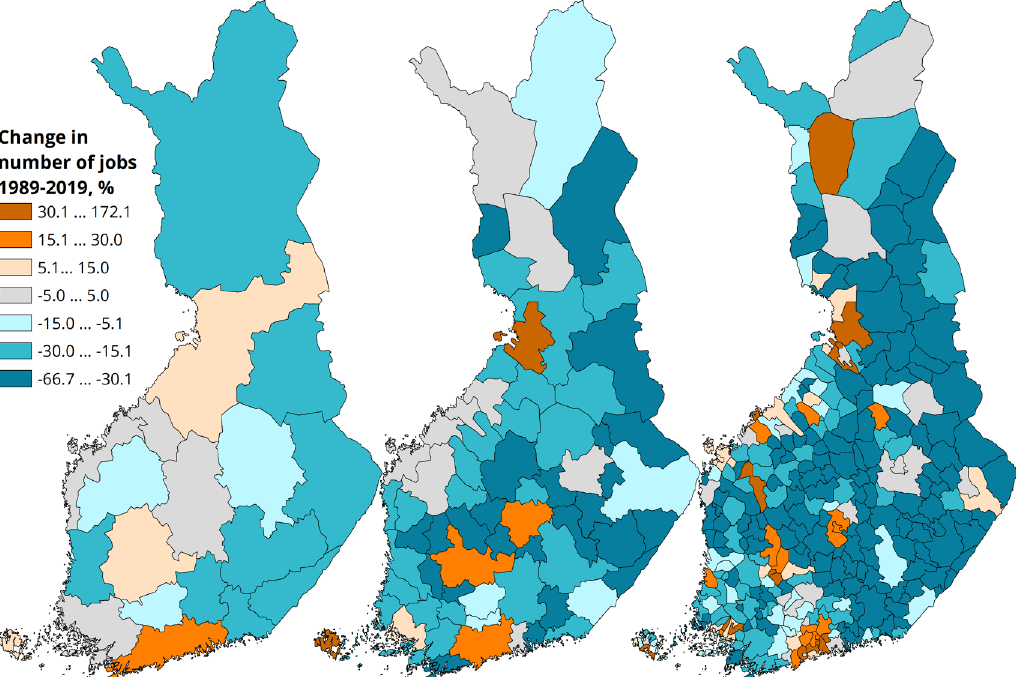
Fig. 8. Changes in regional employment (jobs) in Finland,